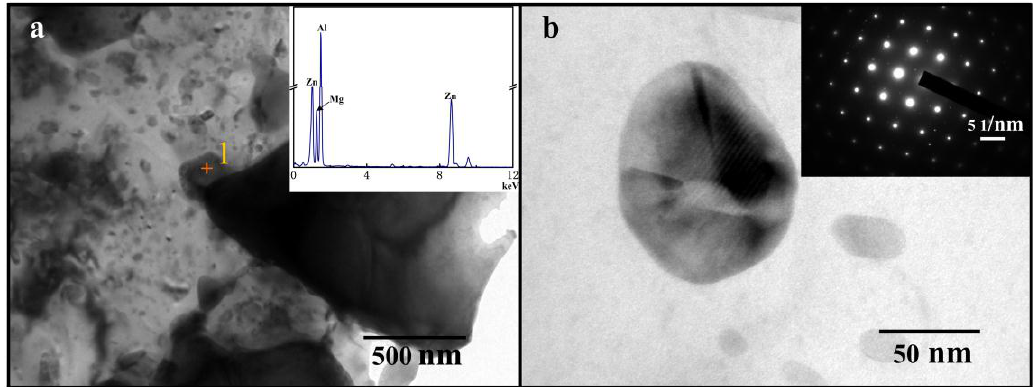
Figure 4. The SEM images of 7075 Al alloys without and with various contents Sr addition: ( a ) 0 wt. % ; ( b ) 0.05 wt. % ; ( c ) 0.1 wt. % ; and ( d ) 0.2 wt. % Sr (the inserts are EDS results for strengthen phases).